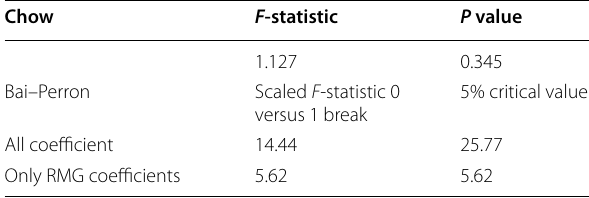
Trimming percentage 25%, Bai–Perron (2003) critical values